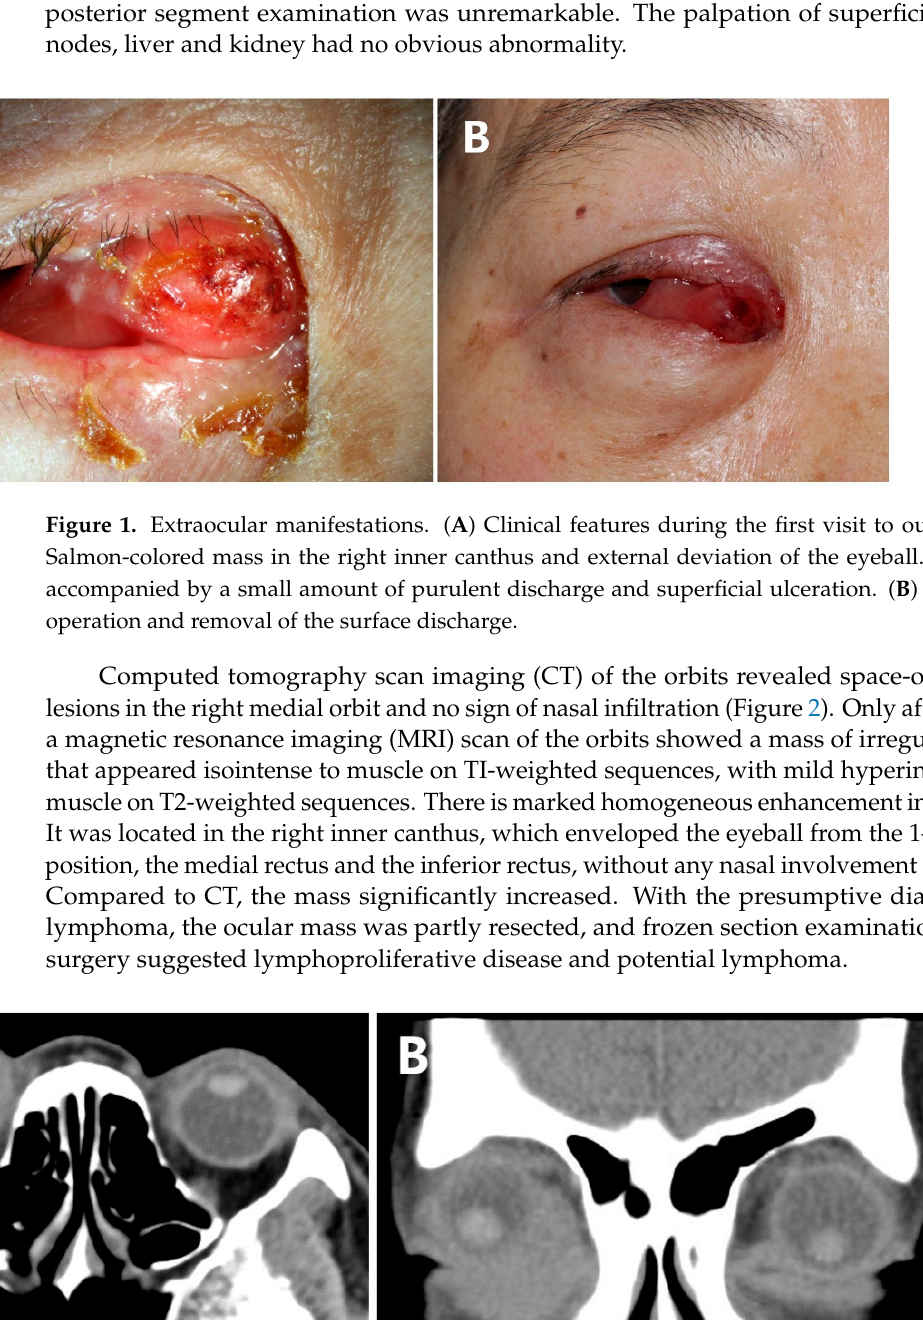
Figure 3. An MRI scan of the orbits showed a mass of irregular shape that appeared isointense on TI-weighted sequences located in the right medial orbital. ( A ) Horizontal view of contrast-enhanced TI-weighted fat-depressed sequences. ( B ) Coronal view on contrast-enhanced TI-weighted se- quences. ( C ) Horizontal view of TI-weighted fat-depressed sequences. ( D ) Horizontal view of T2- weighted fat-depressed sequences. Histopathological examination of the specimen revealed a diffuse lymphoid infiltra- tion composed of atypical lymphocytes with hyperchromic nuclei (Figure 4A). Immuno- histochemical studies were positive for antibodies against cytoplasmic CD3 (Figure 4B), CD56 (Figure 4C) and T-cell-restricted intracellular antigen (TIA-1) (Figure 4D) but nega- tive for CD20, CyclinD1, PAX-5, CD10, CD30, CD15, MUM1, Bcl-6, CD138, Kappa, CD23, and CD163. Some of the neoplastic cells showed expression of CD21, CD5 and Bcl-2. The proliferation index by Ki-67 labeling was more than 80%. In situ hybridization for Epstein- Barr virus (EBV)-encoded small RNA (EBER) was positive, indicated the integrity of EBV mRNA in the tissue samples. On the basis of these findings, primary orbital extranodal natural killer/T-cell lymphoma nasal type was diagnosed. In addition, the EBV DNA copy number was less than 500 copies/mL. Disease is progressing rapidly.